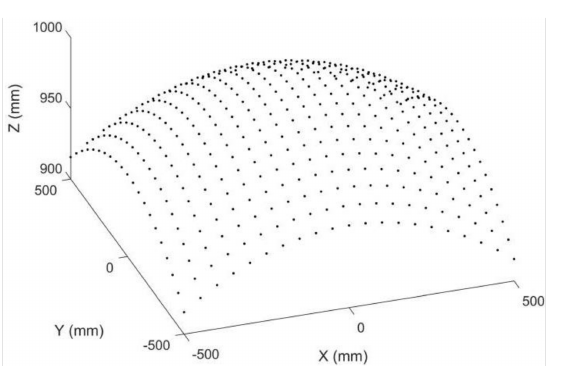
Figure 3. Simulated object points on a spherical surface in anamorphic coordinates of the vertical position.